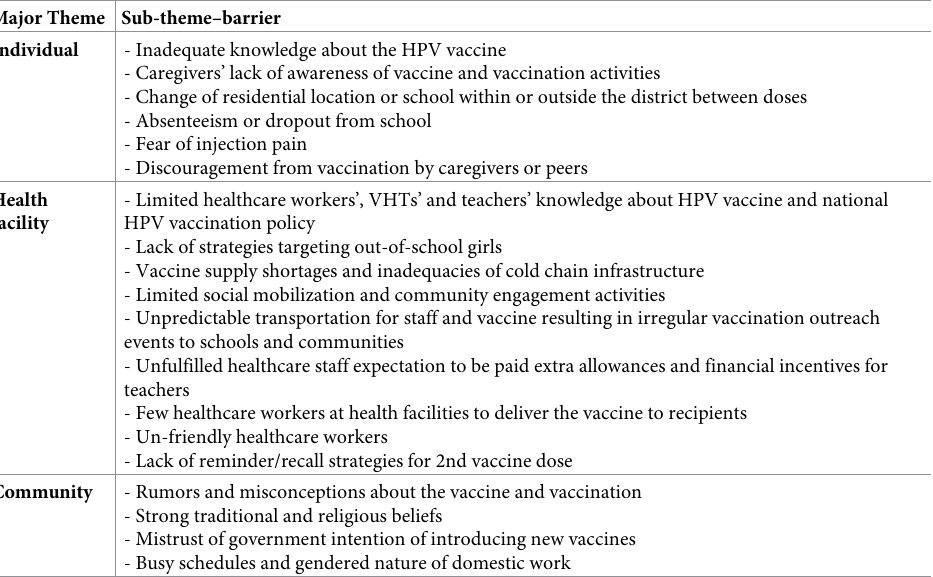
Table 3. Thematic presentation of barriers to HPV vaccination in Oyam